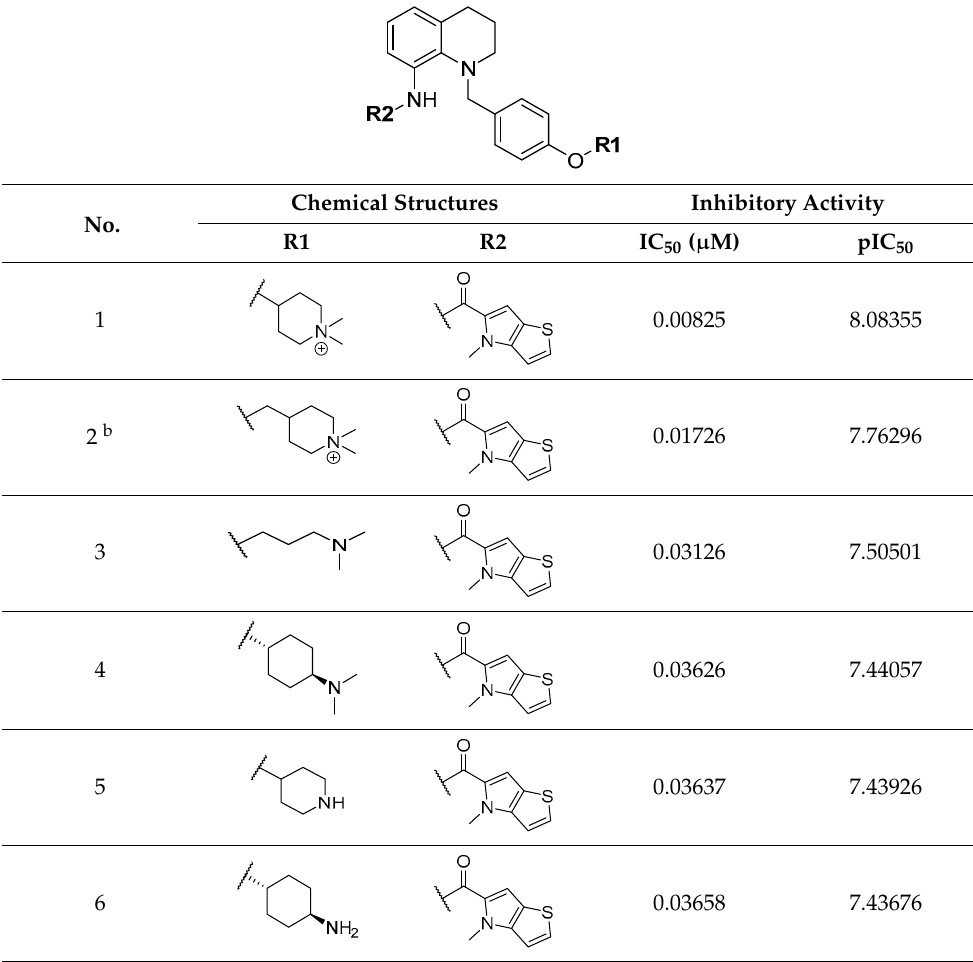
Table 8. Structures and inhibitory activity of tetrahydroquinoline derivatives.